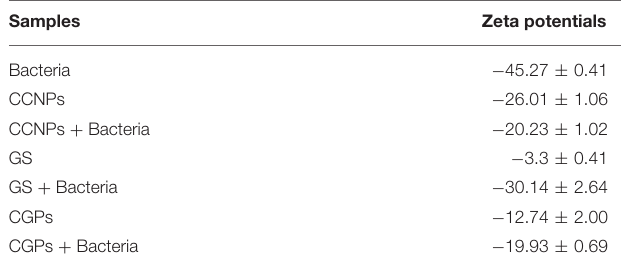
TABLE 3 | ZPs of CCNPs, GS, and CGPs before and after exposure to bacteria for